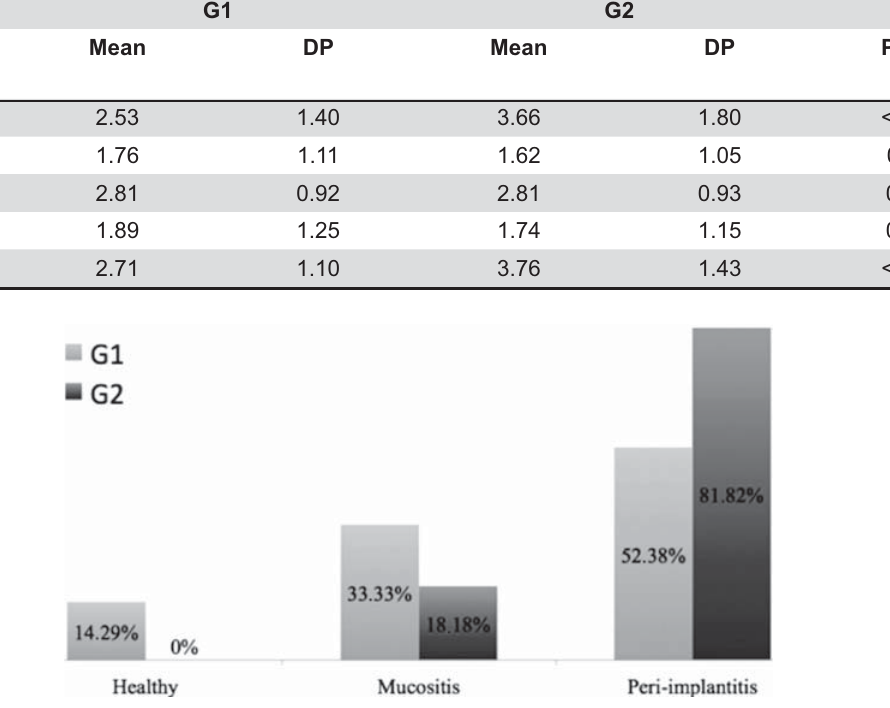
Figure 1- (cid:15)(cid:19)(cid:10)(cid:11)(cid:8)(cid:20)(cid:10)(cid:21)(cid:22)(cid:8)(cid:10)(cid:23)(cid:17)(cid:15)(cid:23)(cid:24)(cid:15)(cid:25)(cid:26)(cid:9)(cid:13)(cid:8)(cid:25)(cid:14)(cid:27)(cid:15)(cid:28)(cid:22)(cid:12)(cid:23)(cid:11)(cid:10)(cid:8)(cid:10)(cid:11)(cid:15)(cid:9)(cid:17)(cid:29)(cid:15)(cid:30)(cid:26)(cid:20)(cid:10)(cid:31)(cid:10)(cid:28)(cid:30)(cid:13)(cid:9)(cid:17)(cid:8)(cid:10)(cid:8)(cid:10)(cid:11)(cid:15)(cid:30)(cid:9)(cid:8)(cid:10)(cid:26)(cid:17)(cid:8)(cid:11)(cid:15)(cid:21)(cid:26)(cid:8)!(cid:26)(cid:26)(cid:17)(cid:15)"(cid:5)(cid:15)#(cid:18)$(cid:26)(cid:29)(cid:15)(cid:29)(cid:26)(cid:17)(cid:8)(cid:22)(cid:20)(cid:26)(cid:15)(cid:11)(cid:22)(cid:30)(cid:30)(cid:23)(cid:20)(cid:8)(cid:26)(cid:29)(cid:15)(cid:21)(cid:14)(cid:15)(cid:22)(cid:30)(cid:15)(cid:8)(cid:23)(cid:15)&(cid:15) (cid:10)(cid:28)(cid:30)(cid:13)(cid:9)(cid:17)(cid:8)(cid:11)’(cid:15)(cid:9)(cid:17)(cid:29)(cid:15)";(cid:15)#(cid:18)$(cid:26)(cid:29)(cid:15)(cid:29)(cid:26)(cid:17)(cid:8)(cid:22)(cid:20)(cid:26)(cid:15)(cid:11)(cid:22)(cid:30)(cid:30)(cid:23)(cid:20)(cid:8)(cid:26)(cid:29)(cid:15)(cid:21)(cid:14)(cid:15)(cid:28)(cid:23)(cid:20)(cid:26)(cid:15)(cid:8)(cid:25)(cid:9)(cid:17)(cid:15)&(cid:15)(cid:10)(cid:28)(cid:30)(cid:13)(cid:9)(cid:17)(cid:8)(cid:11)’